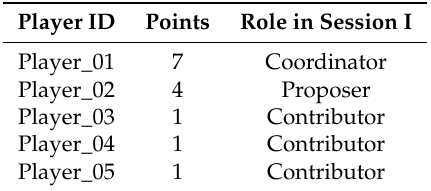
Table 2. Example of leaderboard after the first innovation session.